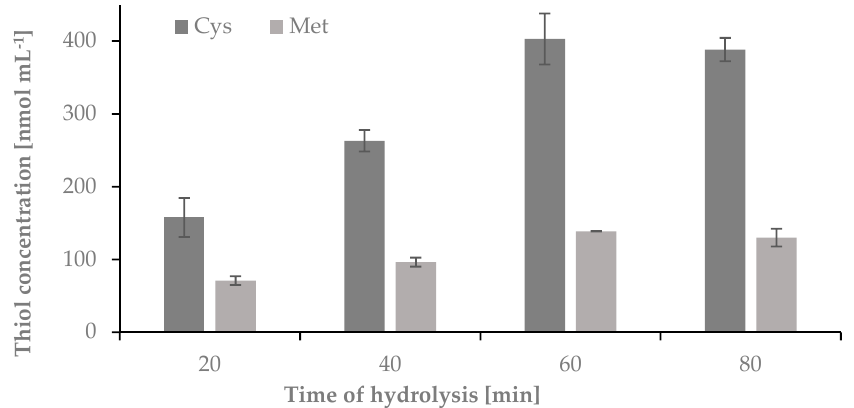
Figure 1. The influence of time on the hydrolysis yield of nail plate samples, measured as signals of cysteine-2-chloro-1-methylquinolinium tetrafluoroborate and methionine- o -phthaldialdehyde-N- acetylcysteine derivatives; n = 3.